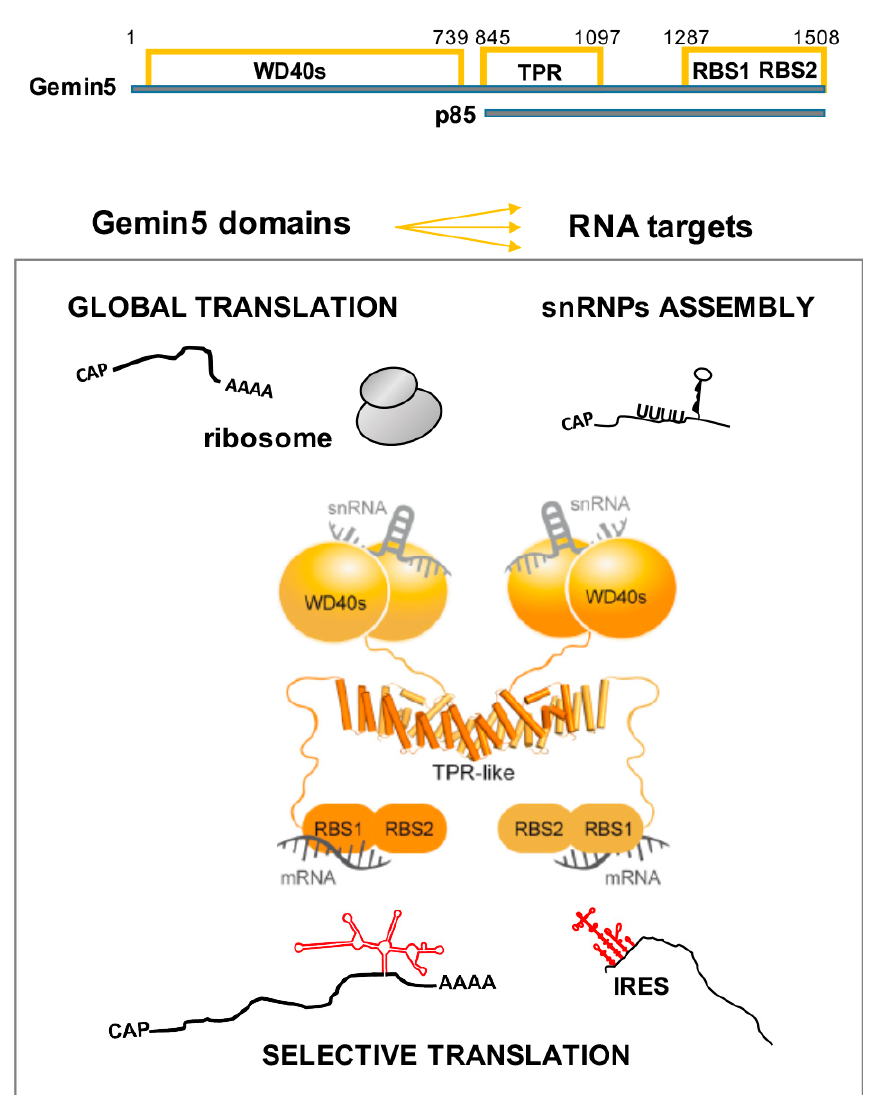
Figure 2. Schematic representation of Gemin5 domains and functions. The amino acids flanking each domain of the protein, as well as the p85 product resulting from the L protease cleavage, are indicated at the top. Known RNA targets of the different domains are depicted in relation to the observed function of the Gemin5 protein. The tetratricopeptide repeat (TPR)-like domain mediates the dimerization of the protein. See text for details on the impact of the indicated domains on the diverse functional roles of the protein.